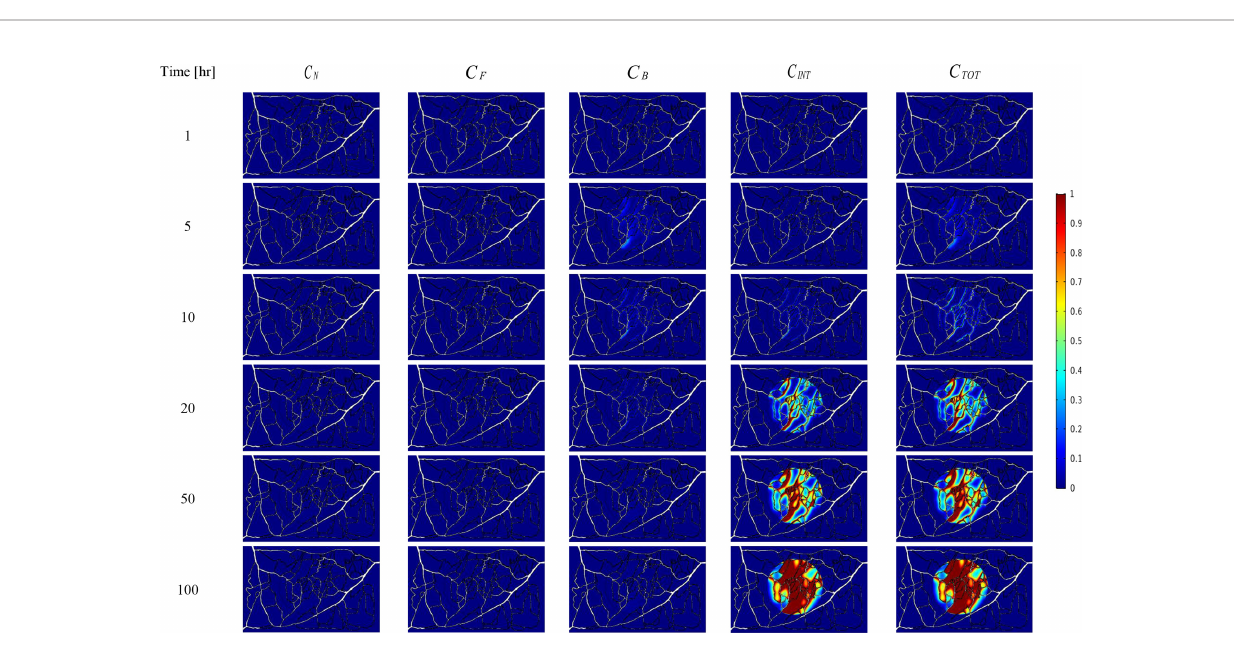
FIGURE 6 | Spatiotemporal distributions of concentrations of drug-loaded NPs in tumor and its surrounding normal tissue with increasing time.